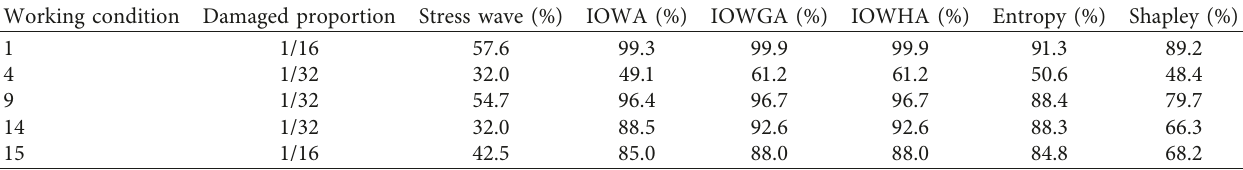
Table 4: Comparison of detected precision and forecasting precision of stress wave tests under several working conditions.